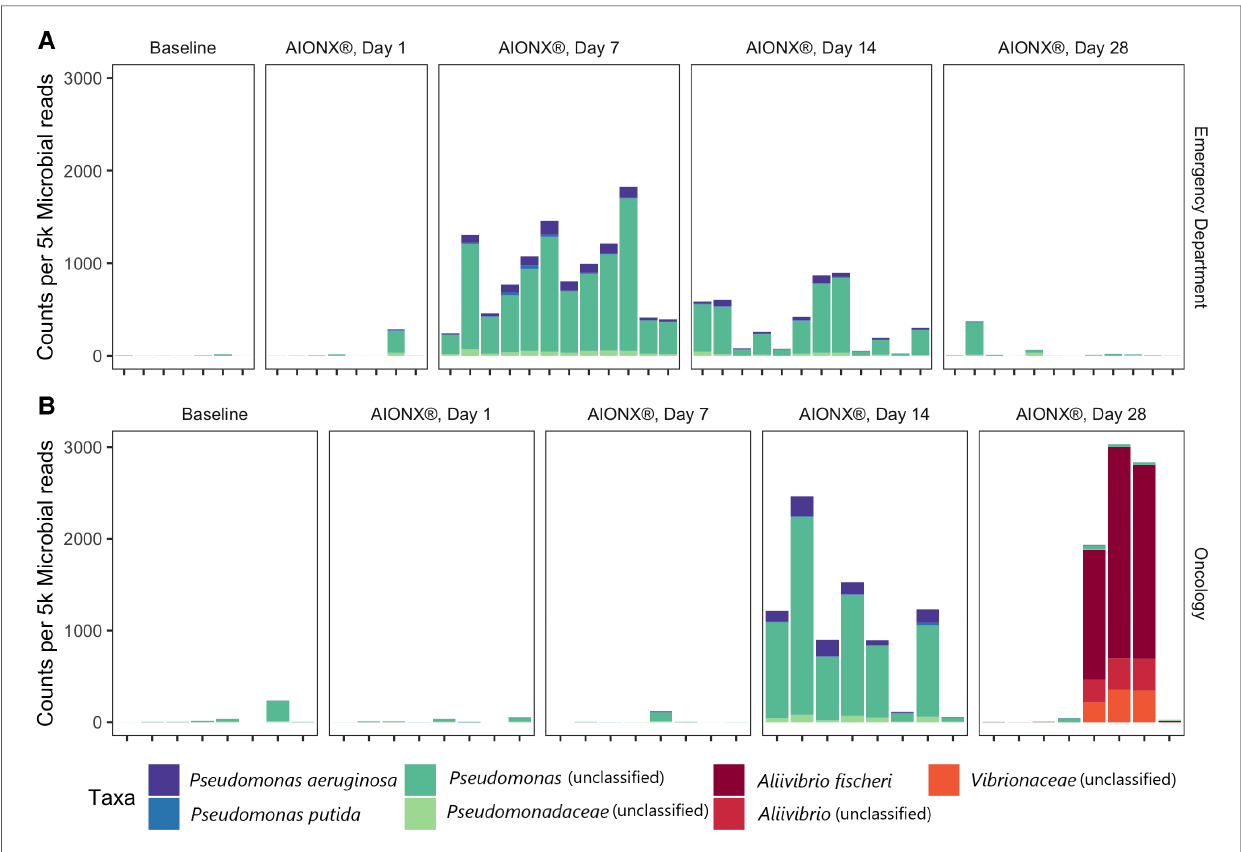
FIGURE 4 Proteobacteria from the orders Pseudomonadales and vibrionales vary over time in the emergency department ( A ) and oncology ward ( B ). Counts are normalized to 5,000 microbial reads per sample and are colored by their most speci fi c taxonomic classi fi cation.